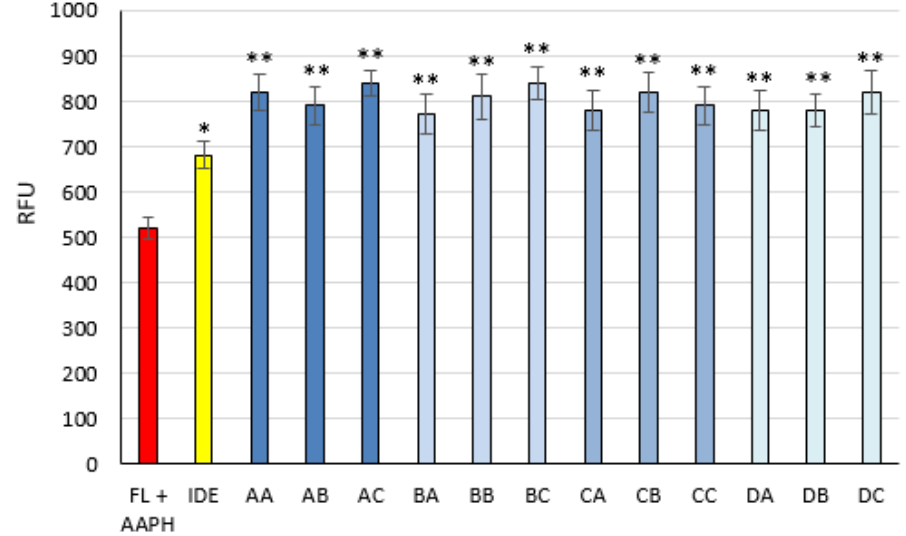
Figure 6. Antioxidant activity of free idebenone (IDE) and formulations AA–DC, expressed as relative fluorescence units (RFU) in the oxygen radical absorbance capacity assay. FL + AAPH = fluorescein + 2,2 azobis (2-aminopropane) dihydrochloride. * Statistically different ( p < 0.05) compared to FL + AAPH; ** statistically different ( p < 0.05) compared to free IDE and FL + AAPH.